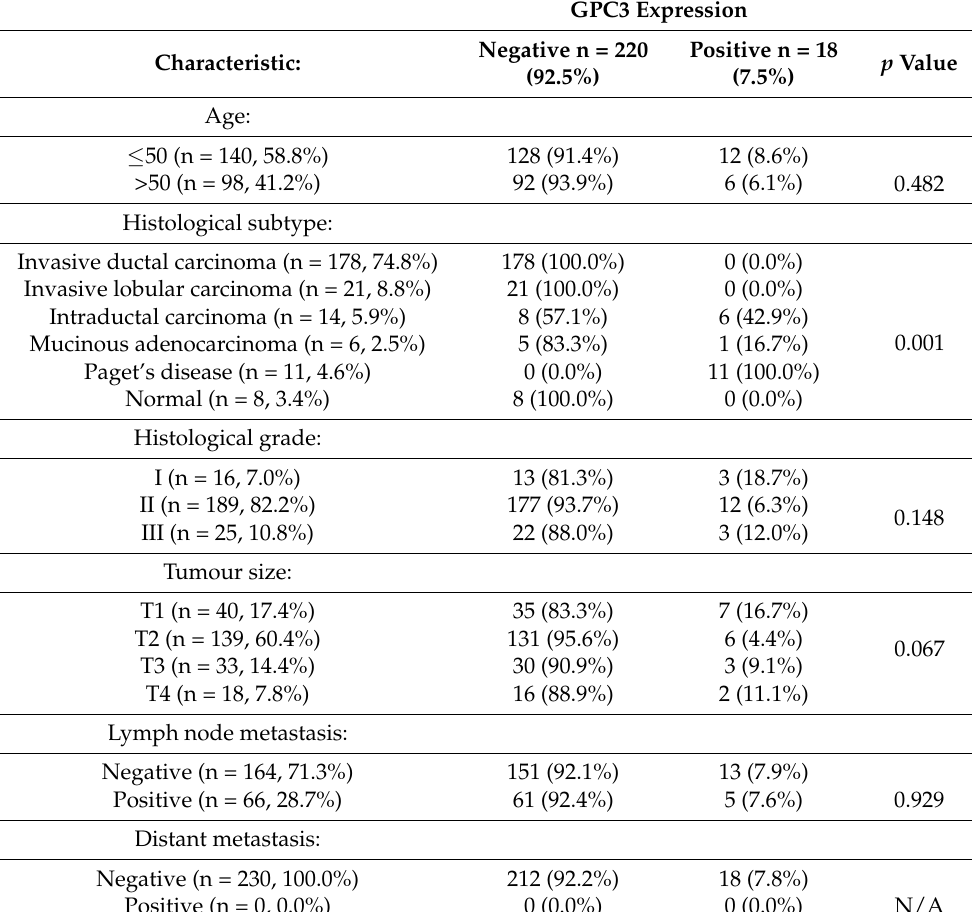
Table 1. Baseline demographic and clinical features of breast cancer